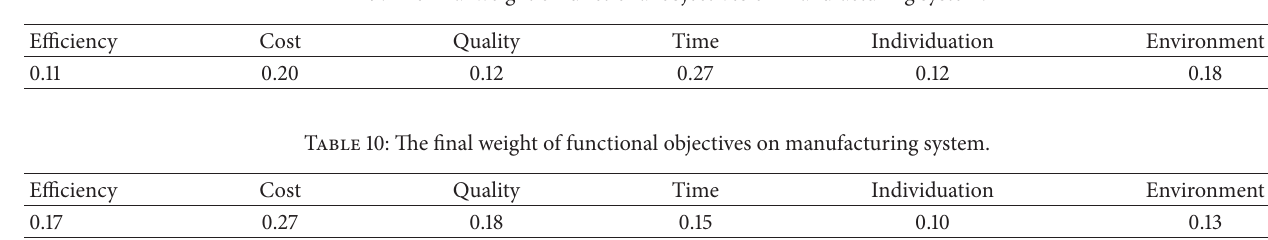
Table 9: The final weight of functional objectives on manufacturing system.